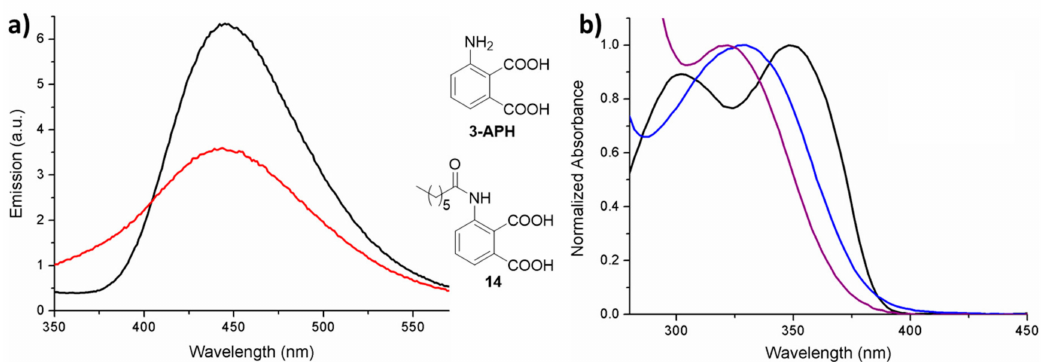
Figure 3. ( a ) Fluorescence spectra of 3APH (black) and 14 (red) ( λ exc = 303 nm, matching absorbance) in aqueous basic solutions. ( b ) Normalized UV–vis spectra of luminol (black), 1a (blue) and 12a (violet) in aqueous basic